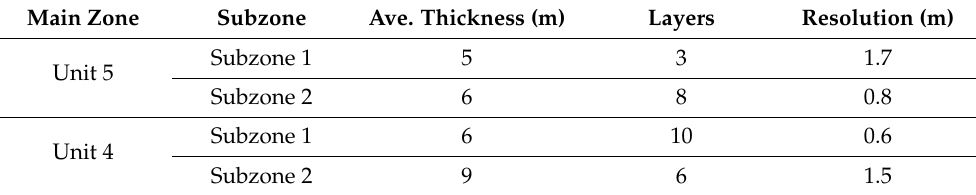
Figure 11. Degree of cells in the orthometric grid system and the direction of the faults. The degree of the cells is set to 20 to make the cells parallel to the fault direction. This will effectively eliminate cell mutation in the grid system. The color lines are the outlines of fault planes and the red lines represent the fault positions in 2D plane view. Table 4. Zone division in the static model of H reservoir and their vertical